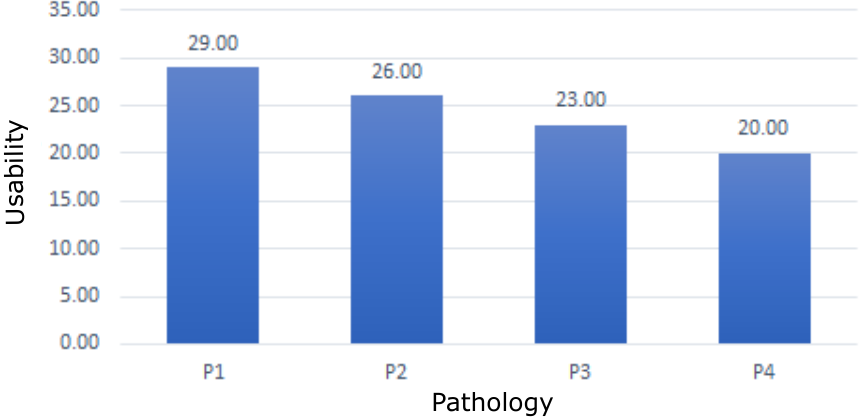
Figure 17. EMKEY usability according to the type of disability. P1: cerebral palsy, P2: upper limb paralysis, P3: spina bífida, P4: Duchenne muscular dystrophy